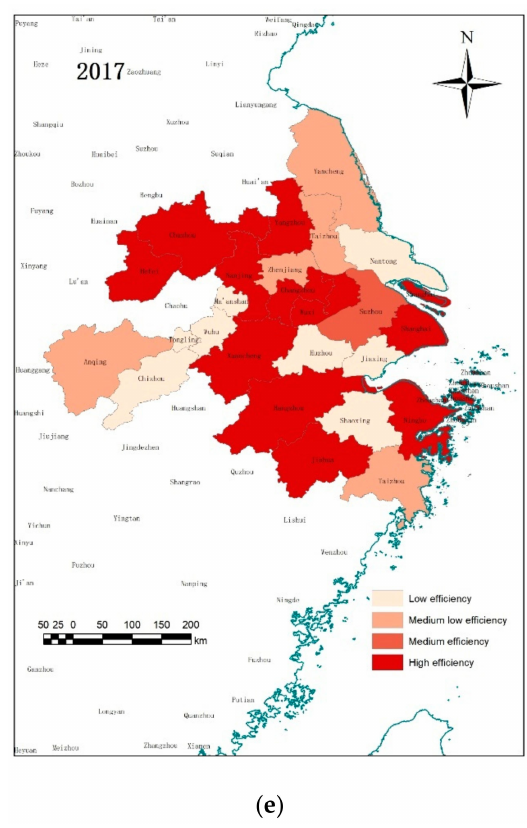
Figure 5. The Spatial Diagram of The Urban Land Use Efficiency. ( a ) The urban land use efficiency in 2003. ( b ) The urban land use efficiency in 2007. ( c ) The urban land use efficiency in 2011. ( d ) The urban land use efficiency in 2014. ( e ) The urban land use efficiency in